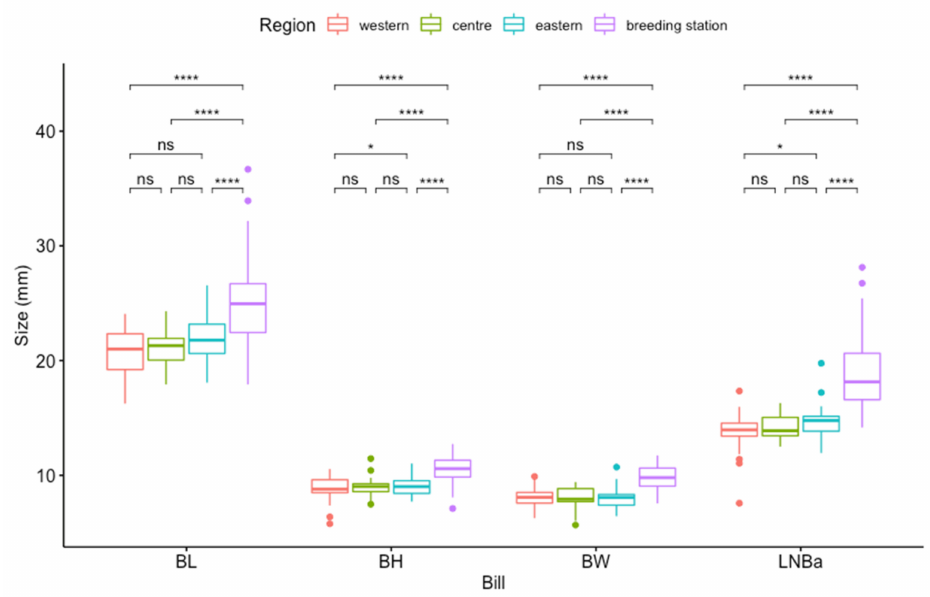
Figure 5. Comparison of bill length by regions. ns: nonsignificant, *: p < 0.05, ****: p < 0.0001.